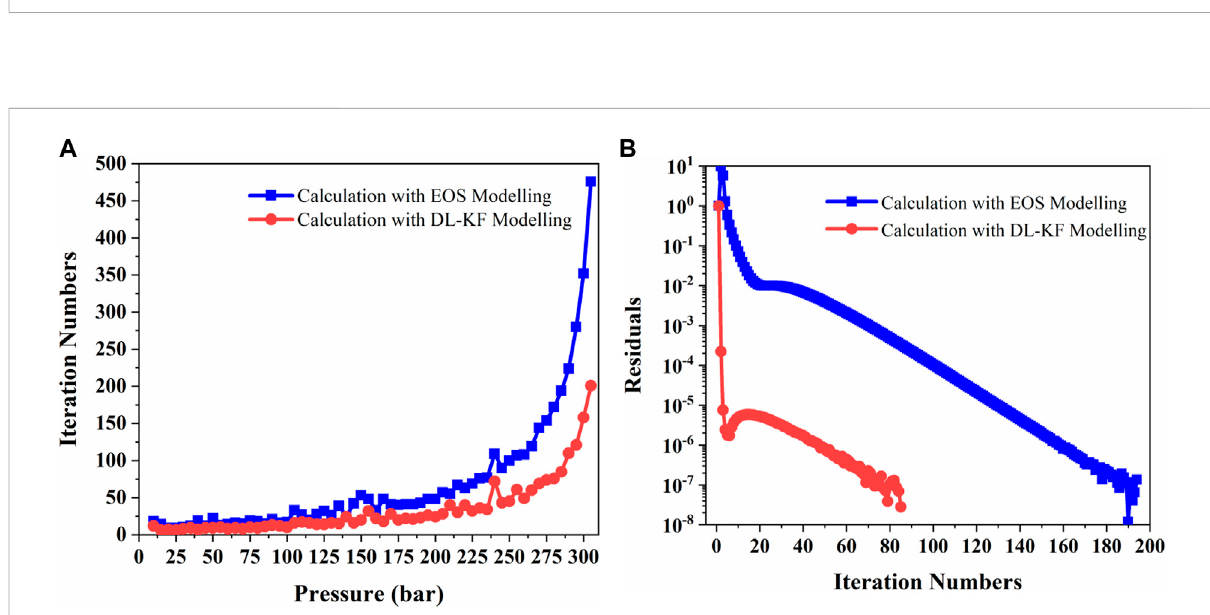
FIGURE 13 Comparison ofiterationnumbersneededtoreachthesolution (A) andtheconvergencebehavior (B) betweentheDL-KFmodelingandoriginal EOS